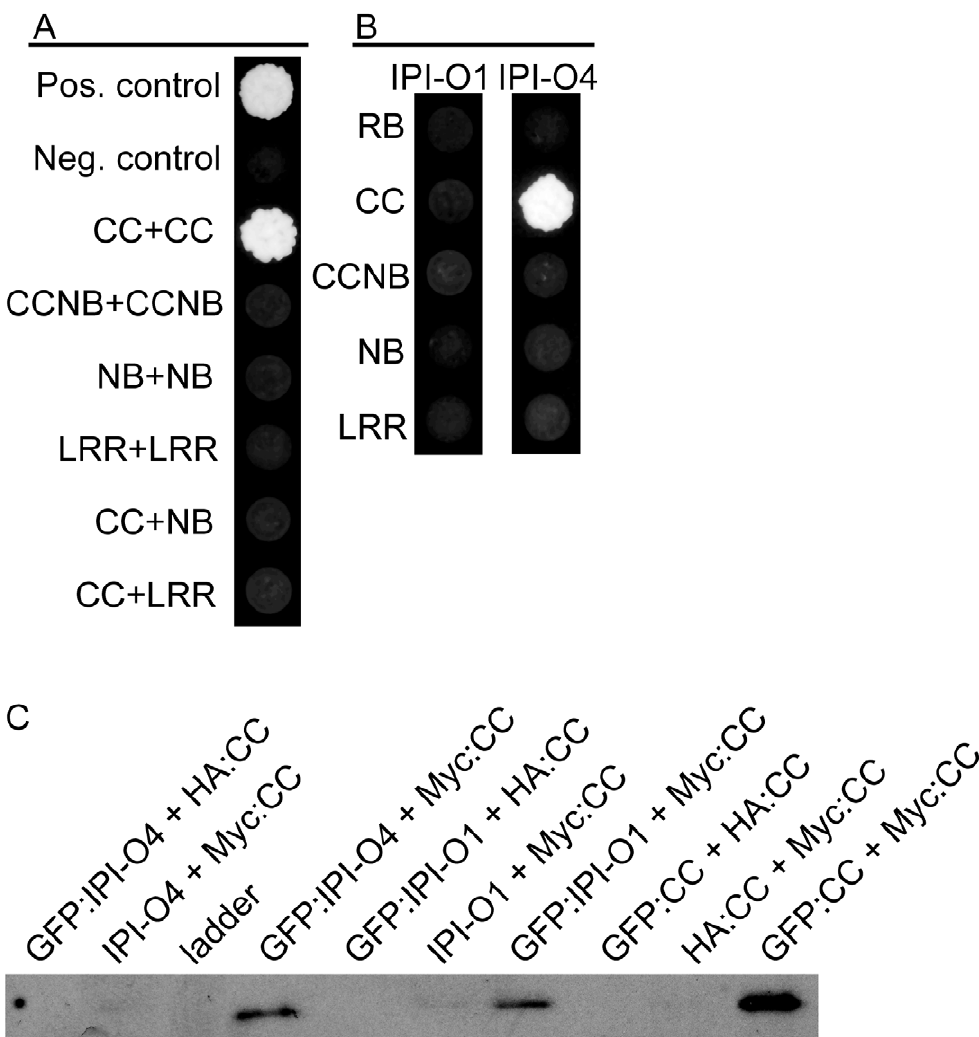
Figure 1. Inter- and intramolecular interactions between RB protein domains and IPI-O effectors. A) Yeast two-hybrid interactions between domains of RB or domain self-association; B) Interactions between domains of RB and IPI-O1 or IPI-O4; C) Results of co-immunoprecipitation of RB CC domain with IPI-O fusion proteins. The indicated protein combinations were expressed in N. benthamiana leaves and total proteins were incubated with green fluorescent protein (GFP) antibody and agarose beads. Precipitated proteins were detected using Myc-tag antibody. Proteins with no fusion or with a hemagglutinin (HA) tag were used as negative controls.